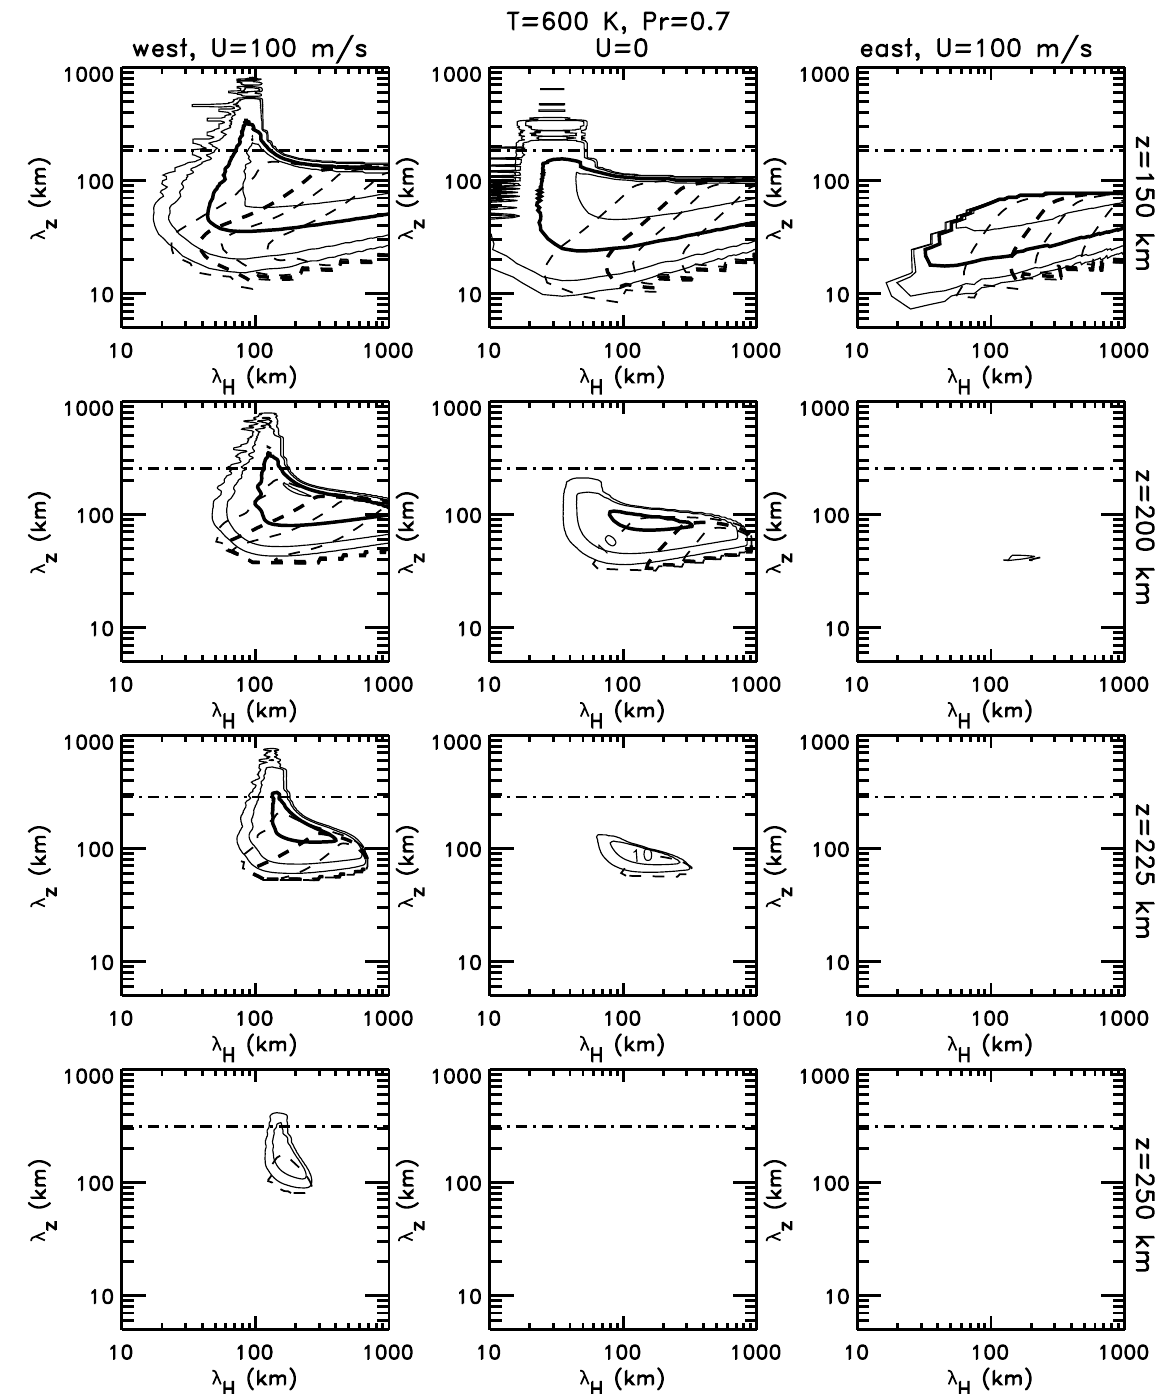
Fig. 6. Contour plots of momentum flux magnitudes as functions of horizontal and vertical wavelength at minimum solar forcing ( ∼ 600K thermospheric temperature) for GWs propagating westward, meridionally (i.e. no wind), and eastward (left, center, and right panels, respec- tively) for the wind profile shown with a solid line in Fig. 1c. Successive plots are at altitudes of 150, 200, 225, and 250km (top to bottom, respectively). Contour intervals are 0.9, 0.5 (bold), 0.1, and 0.03, and dashed contours indicate observed GW periods of 10, 20 (bold), 30, and 60min. Vertical wavelengths are not reliable near the value of 4 πH (shown with the horizontal dashed line in each panel) because the WKB assumption is violated at these